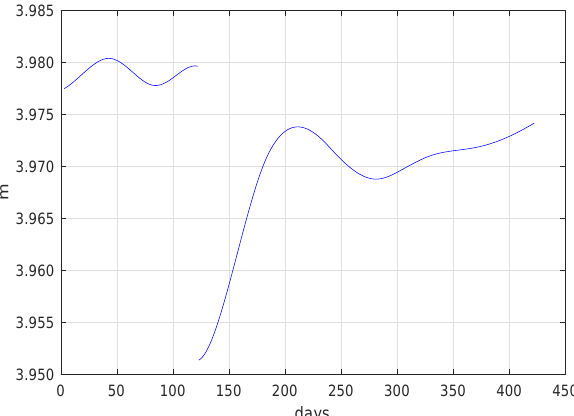
Figure 16. Modelled relative distance between the West and East points during the observed